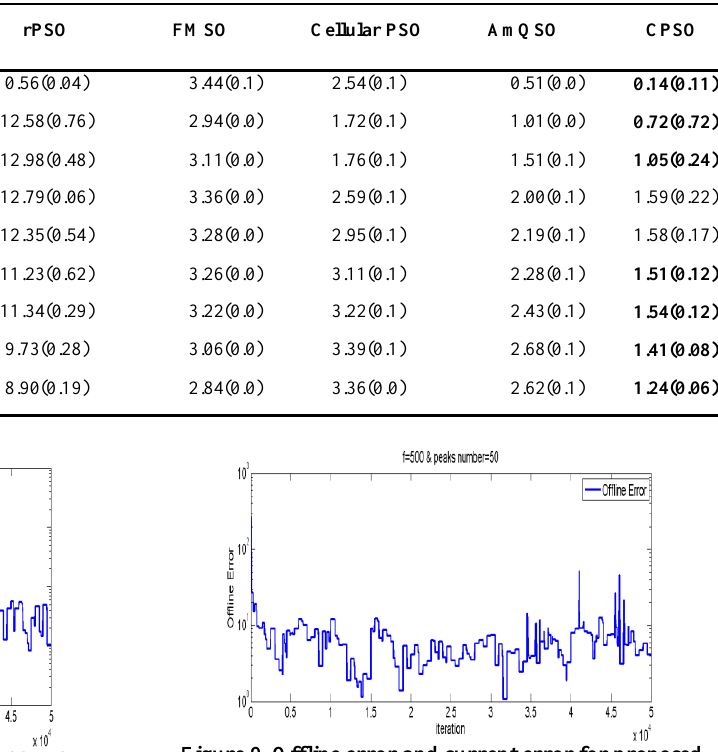
Figure 9. Offline error and current error for proposed algorithm in frequency = 500 and peak number = 50.